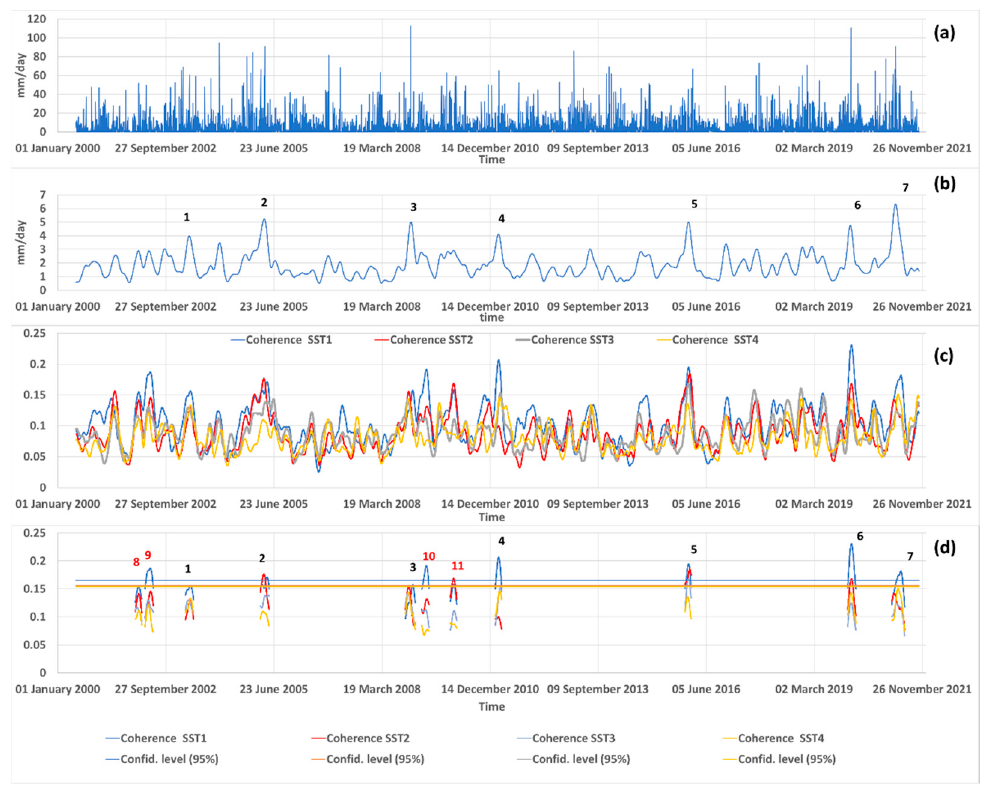
Figure 4. ( a ) Daily precipitation depth averaged over the region (86° W, 82° W) × (33° N, 37° N); ( b ) amplitude of rainfall depth in the 22.8–45.7-day band (1/12-year harmonic); ( c ) coherence of the precipitation depth and the SST anomalies in the five regions; ( d ) selection of coherences such that the coherence with respect to SST1 is greater than 0.15.